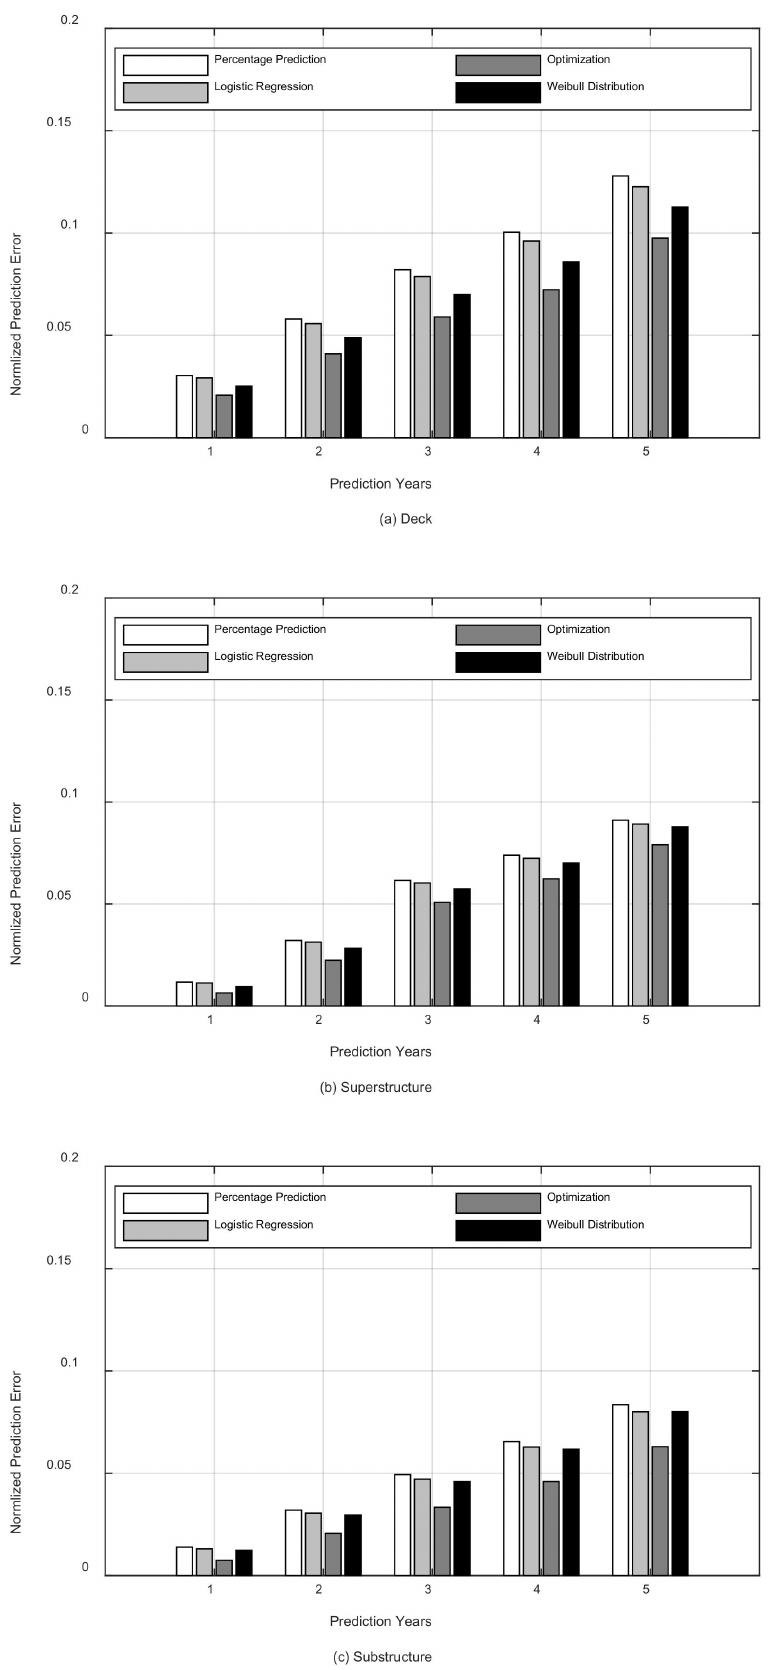
Figure 13. Normalized prediction error comparison of stochastic methods depending on prediction years for ( a ) deck, ( b ) superstructure, and ( c )